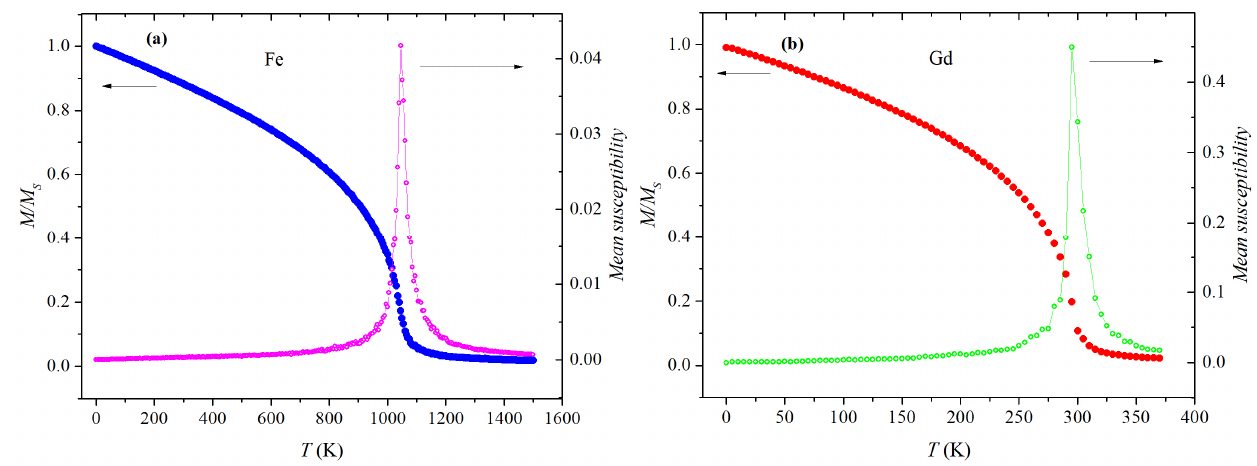
Figure 2. Simulations of the dependence of normalized magnetization and mean susceptibility on the temperature for bulk bcc ‐ iron ( a ) and hcp ‐ gadolinium ( b ) materials.